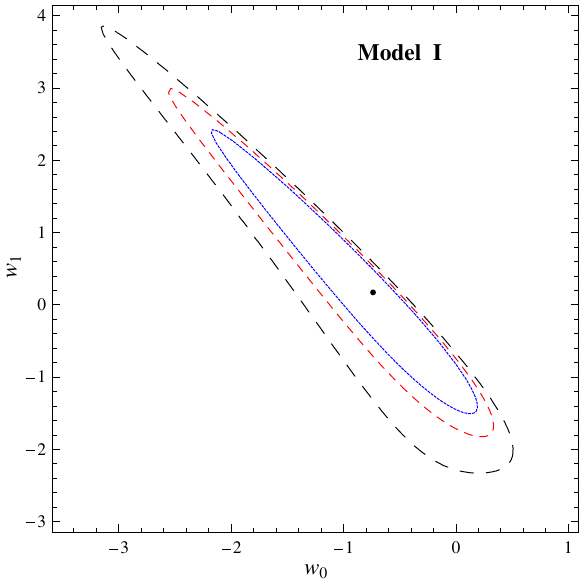
Fig. 1 Variations of w 0 and w 1 in the joint analysis (SNIa+BAO+CMB+Hubble) for the linear parameterization (Model I). We plot the graphs for different confidence levels 66% (solid, blue), 90% (dashed, red) and 99% (dashed, black) contours for ( w 0 , w 1 ) by fixing the other parameters β = − 0 . 5 , D = 5 ,w m = − 0 . 3 ,ω =